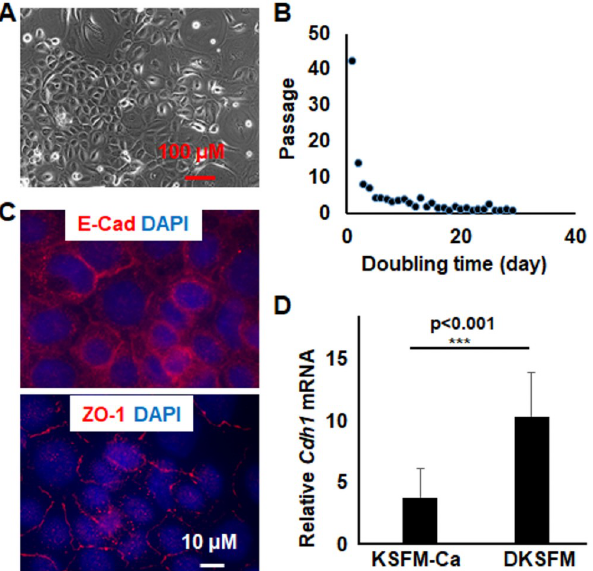
Fig 4. Characterization of epithelial cells adapted in DKSFM media. Cells adapted to grow in DKSFM were (A) examined with microscope and bright-field images captured, (B) examined for growth rate through the calculation of doubling time at different passages, (C) subjected to immunofluorescence staining using antibodies for E-Cad and ZO- 1, and images were captured with Zeiss fluorescent microscope, and (D) measured for E-Cad ( Cdh1 ) expression by qPCR and expression was compared to that in mESCs as 1. Results represent duplicate data of at least 3 biological samples.